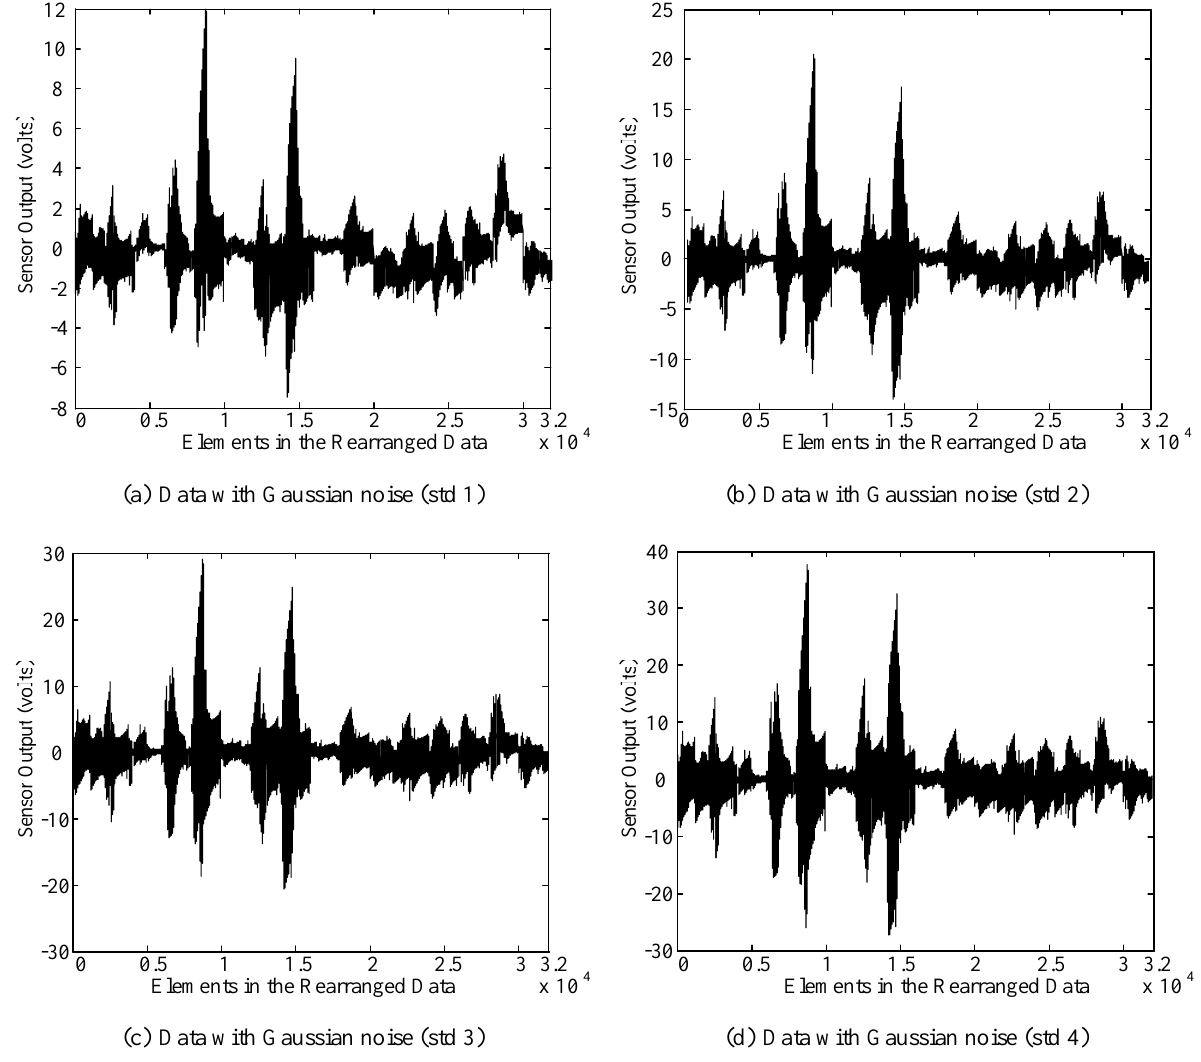
Figure 6. E-Nose data with Gaussian noise of standard deviation